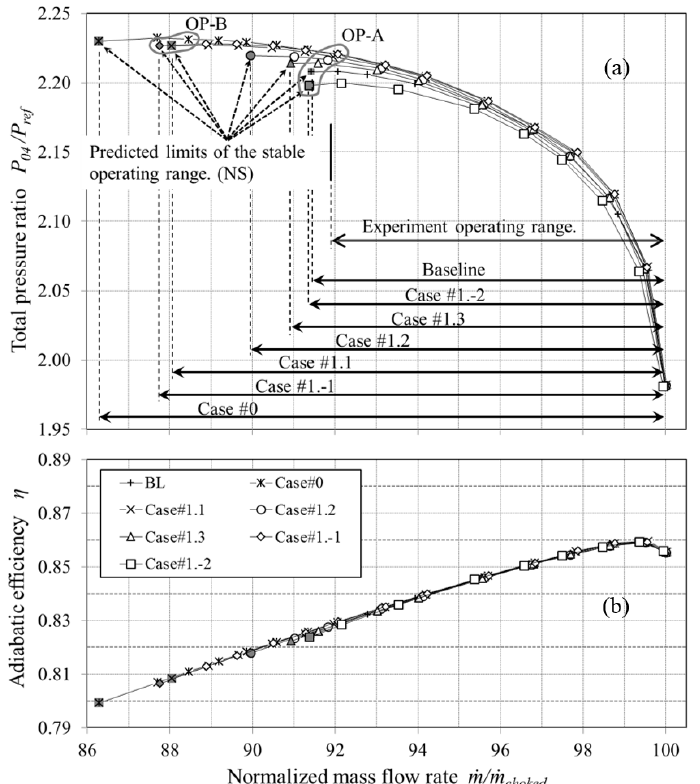
Figure 6. Overall compressor performance characteristics showing the influence of the RC location. ( a ) Influence of the RC location on the total pressure ratio across the rotor at different normalized mass flor rates. ( b ) Influence of the RC location on the rotor adiabatic efficiency ad different normalized mass flow rates.